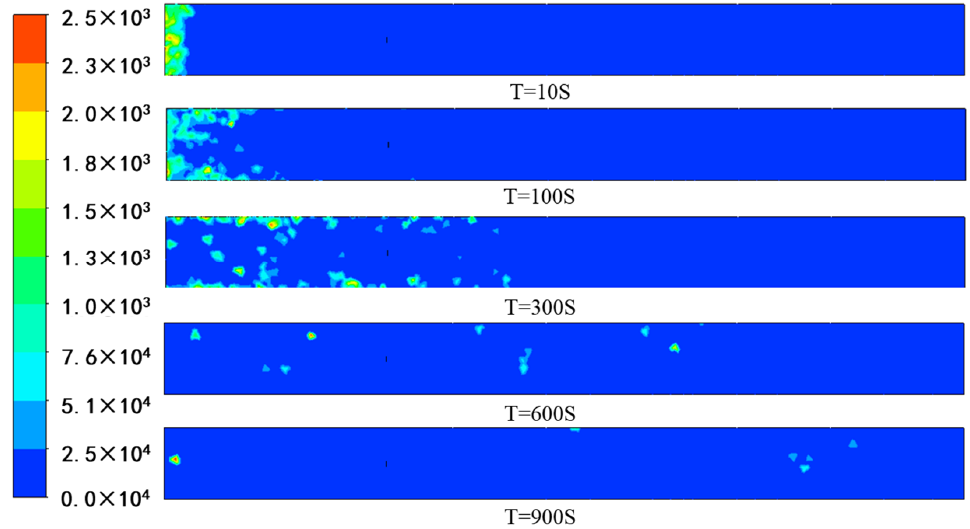
Figure 4. Distribution of blasting dust concentration at a 1.5 m height.